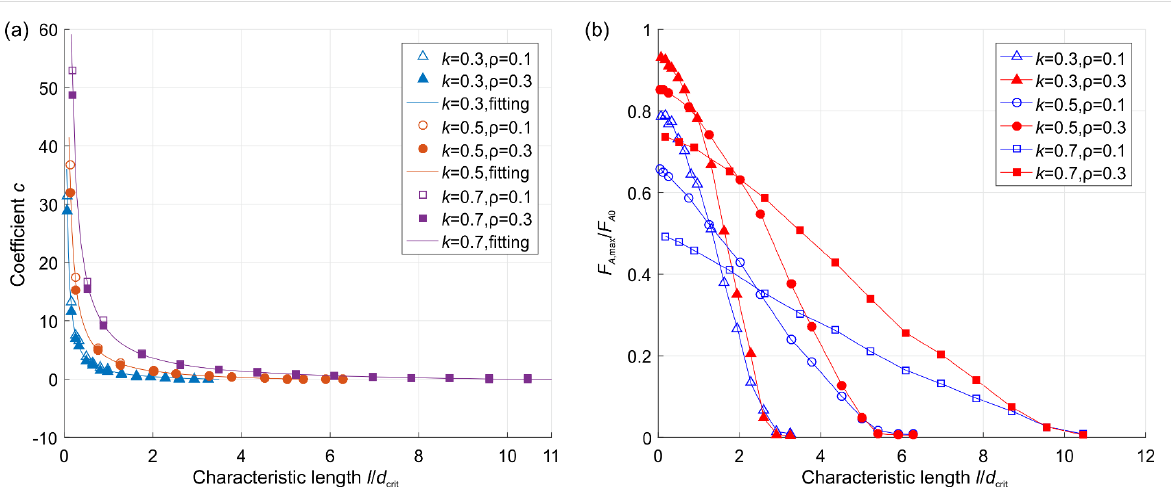
Figure 6: (a) Dependence of adhesion coefficient on the normalized roughness in region I (Figure 4) for different exponents k ; (b) the maximum value of adhesive force at the plateau (region III, Figure 4) for different exponents k .